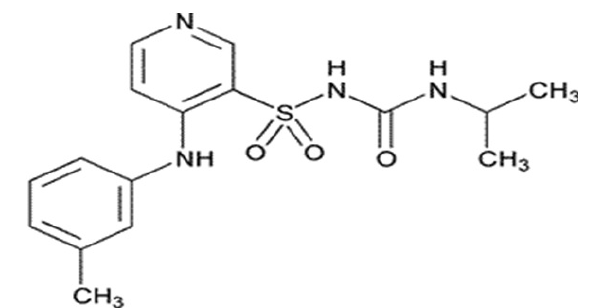
FIGURE 1 - Chemical structure of Torsemide.